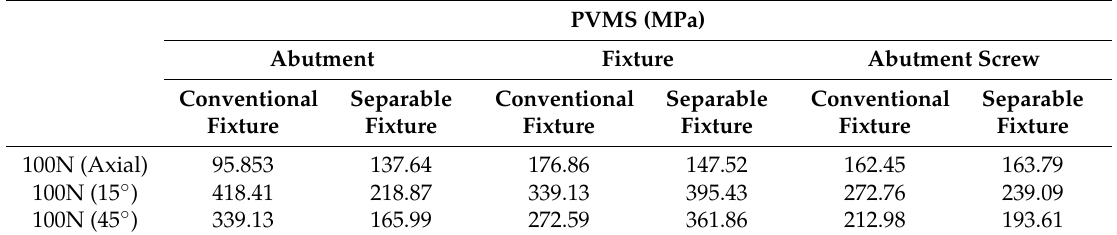
Table 4. PVMS results of the conventional and separable fixtures for abutment, fixture, and abutment